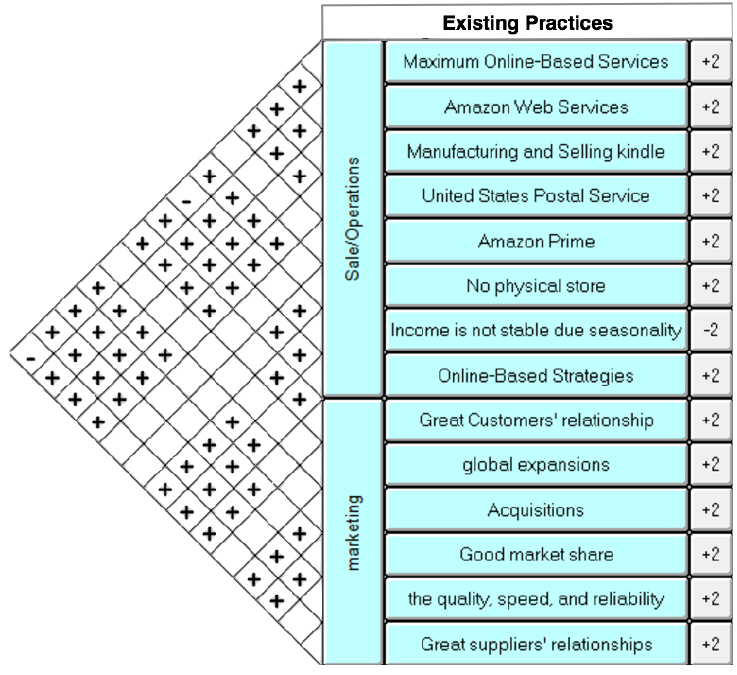
Fig. 9. Amazon Matrix of Change Current